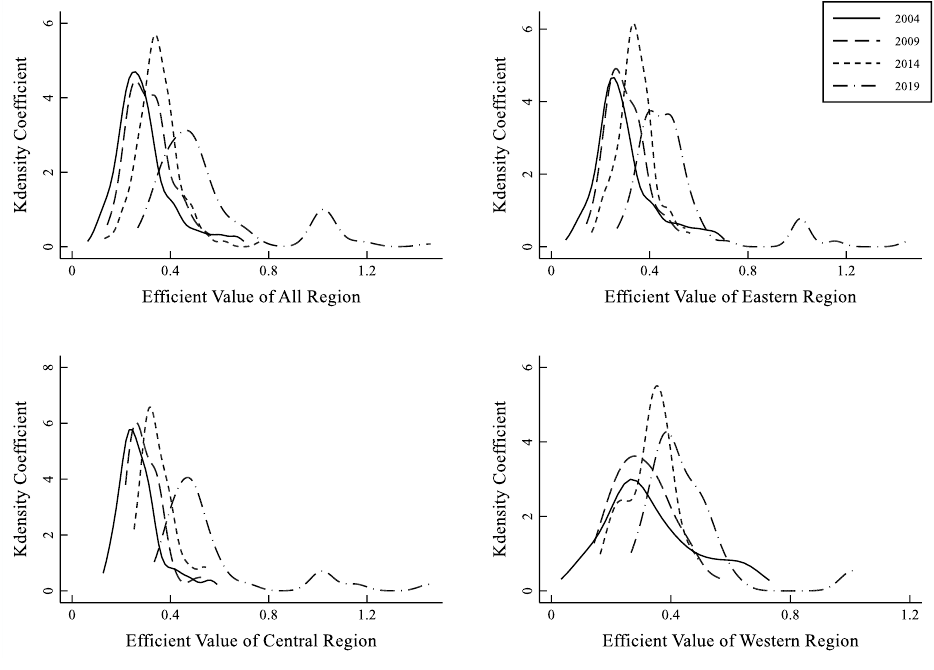
Figure 4. Kernel density map of ULUE.